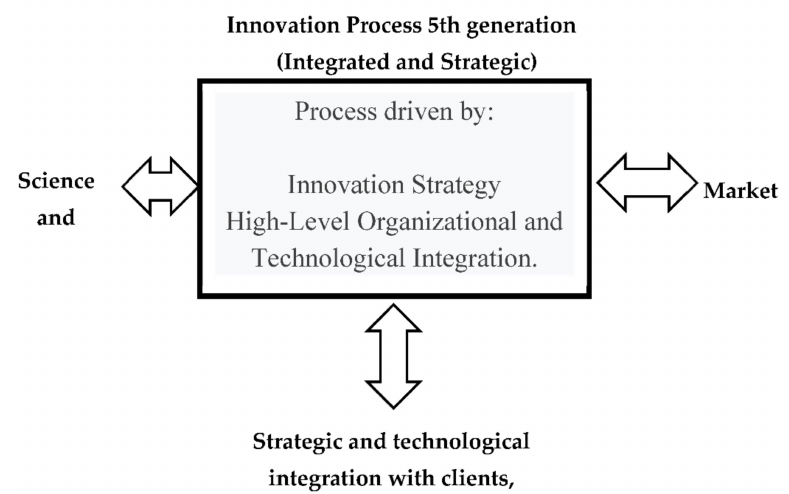
Figure 5. Dodgson model. Source: Dodgson et al.,